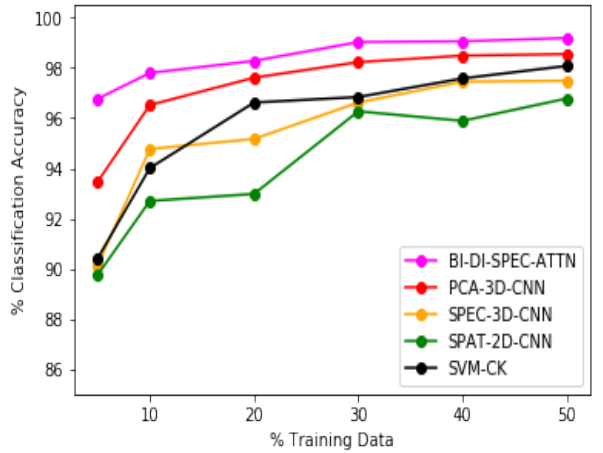
Figure 7. Overall classification accuracies on Pavia University dataset for varying sizes of training